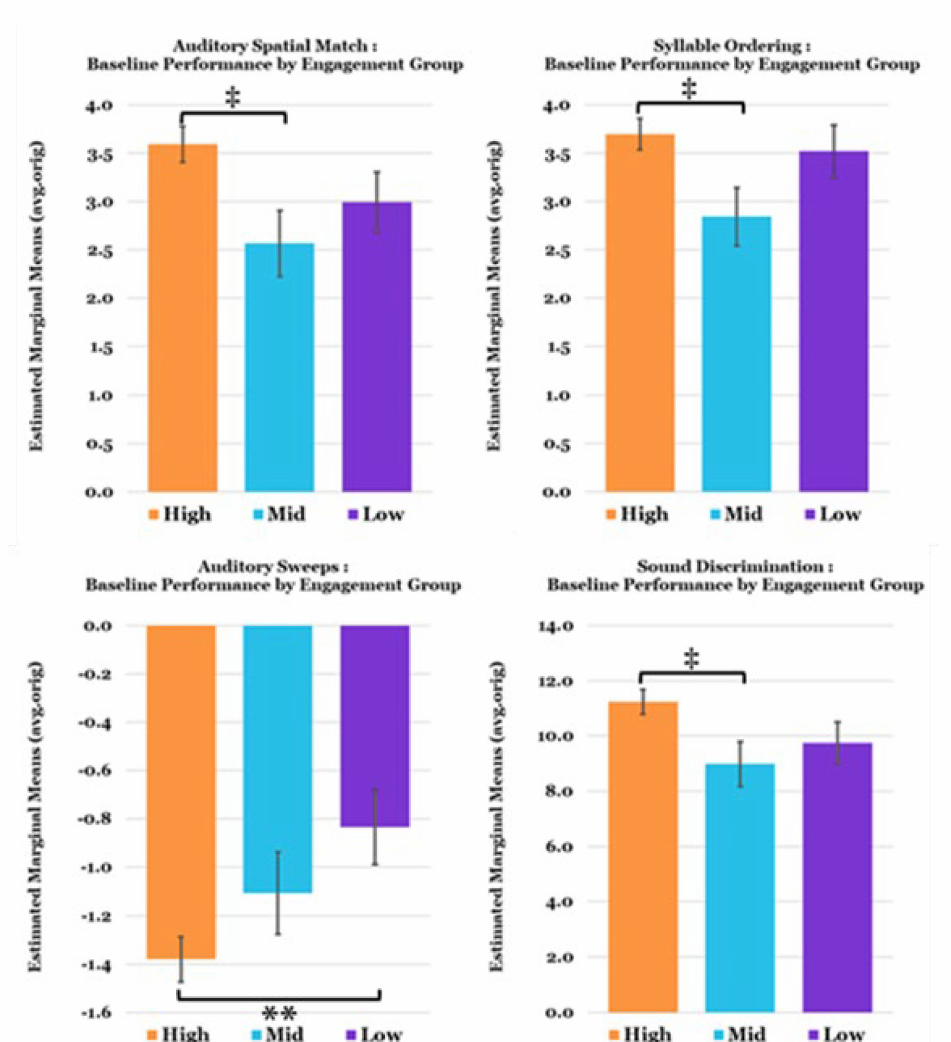
Figure 4. Mean baseline TCT exercise performance by Engagement Group (Mean Levels completed: High = 640; Mid = 322; Low = 42.8). Note that negative values on the performance metric for Auditory Sweeps exercise indicate better performance (faster auditory processing speed). Covariates appearing in the model are evaluated at the following values: Age = 17.0, Sex = 0.18. Error Bars = ± 1 SE; ** p < 0.01, ‡ p < 0.10